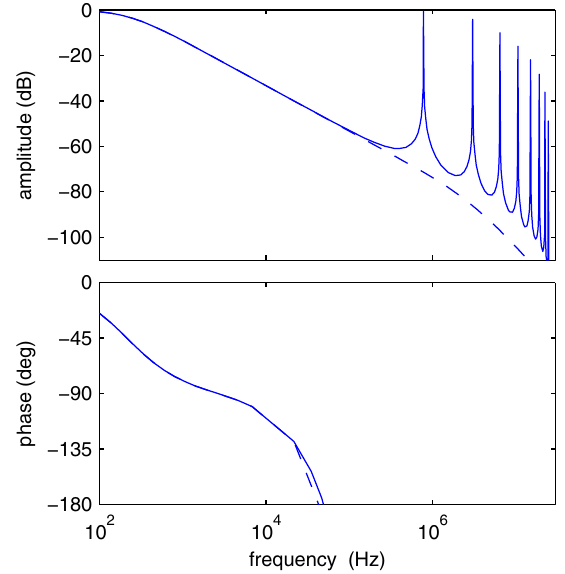
FIG. 4. (Color) Bode plot of the continuous single cavity open loop transfer function (7) with unity gain ( G (cid:3) 1 ) and loop delay (cid:3) 5 (cid:1) s . At the dashed line all FMs with exception of the (cid:4) loop (cid:2) -mode have been omitted. Plotting the amplitude and phase response of the open loop transfer function